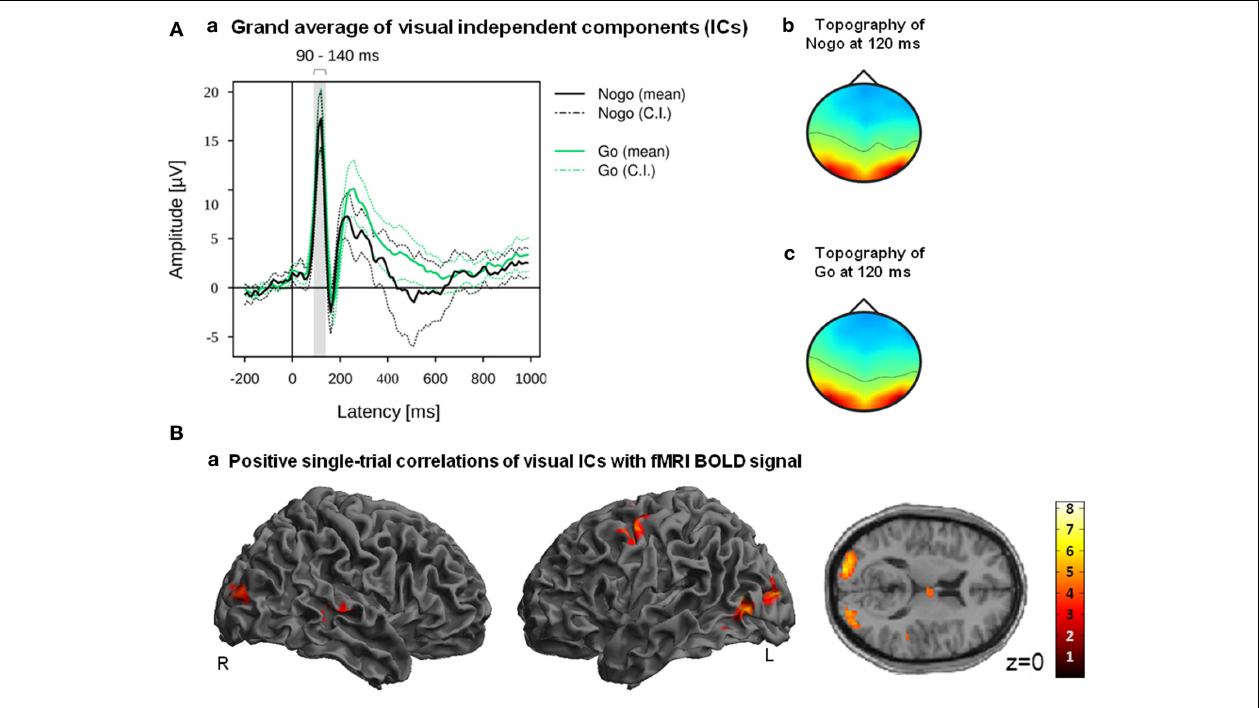
FIGURE 5 | (A) Grand averages (a) and grand mean IC topography (b) of all participants ICs which were classified as reliable related to visual processing within the latency range of 90–140ms. Mean and 95% confidence interval (CI) of Nogo (black lines) and Go (green lines) are displayed in solid and dotted